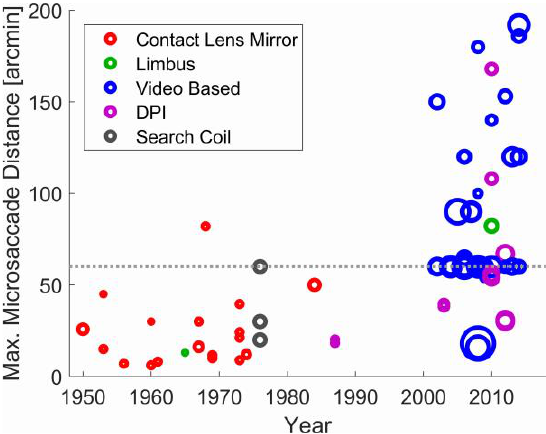
Figure 3: Maximum microsaccade size by year of publica- tion. The area of each circle is scaled in relation to the num- ber of participants. The circle colour represents the type of eye tracker. The dashed grey line indicates a 1° microsac-